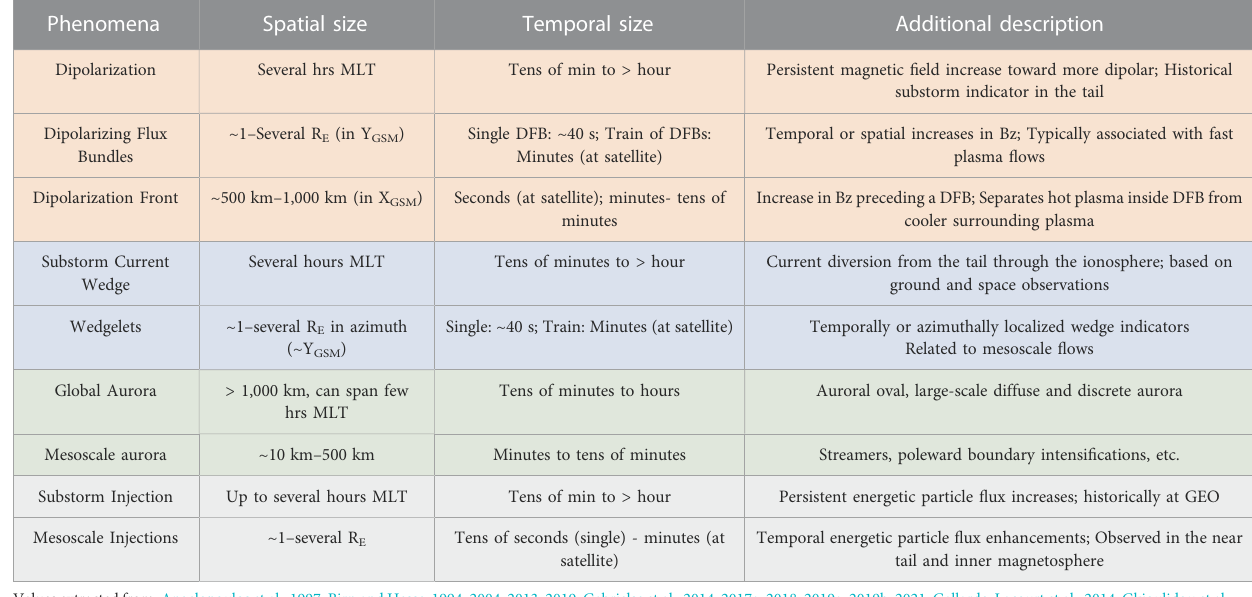
TABLE 1 Global vs. Mesoscale Phenomena in Earth ’ s Magnetotail and its Transition Region.